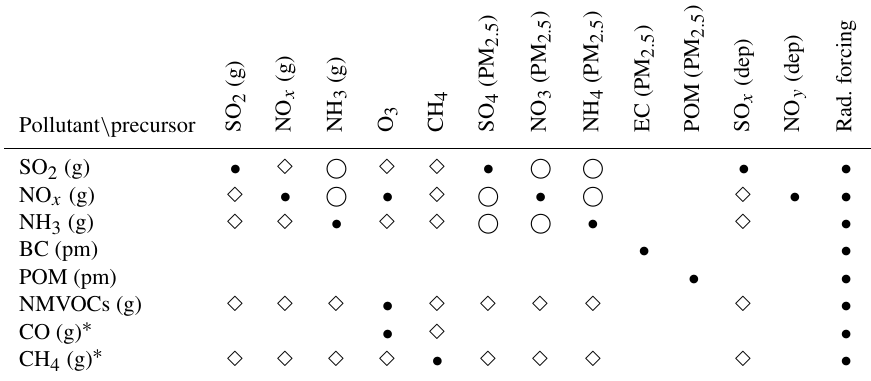
Table 1. Relevant precursor–pollutant relationships included in TM5-FASST. • : direct emission or immediate product; (cid:13) : effect via ther- modynamic equilibration; : effect via first-order oxidation products (OH) affecting the lifetime of other precursors. (cid:51)